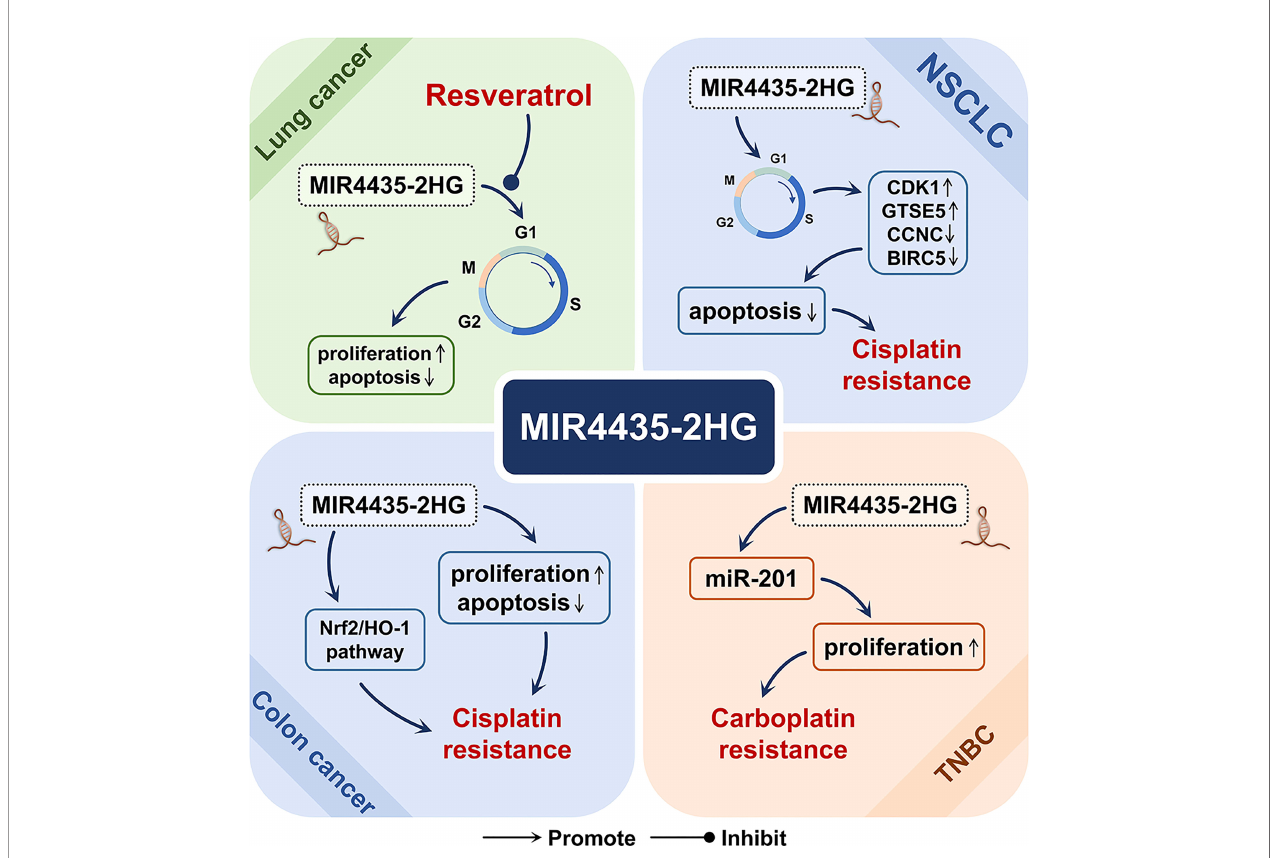
FIGURE 7 | The role of MIR4435-2HG in cancer drugs. In lung cancer, MIR4435-2HG may be involved in the inhibitory effect of resveratrol on the growth of lung cancer cells. In non-small cell lung cancer (NSCLC) and colon cancer, MIR4435-2HG may be a driving factor for cisplatin resistance. In triple-negative breast cancer (TNBC), MIR4435-2HG may be involved in the development of carboplatin